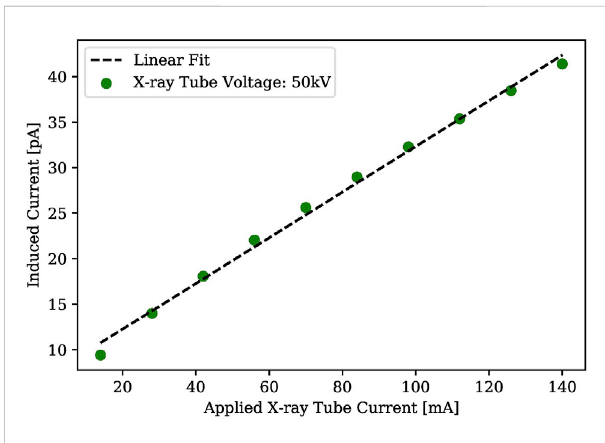
FIGURE 13 X-ray induced current of an Ag/Cs3Bi2Br9/Ag device using of varied X-ray tube current (X-ray Tube Voltage: 50kV, Bias voltage: